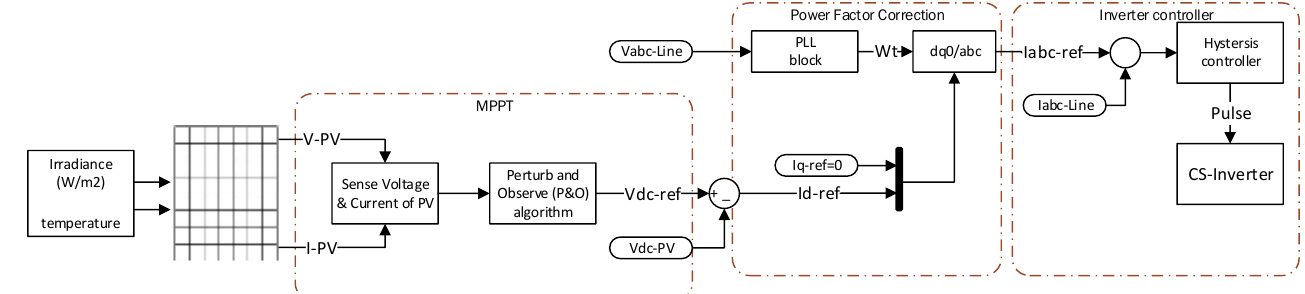
Figure 6. Perturb and Observe (P&O) algorithm